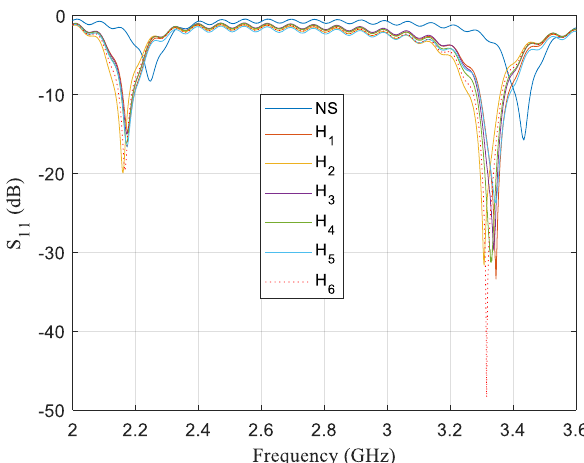
Figure 8. Frequency response of a 13 mm circular sensor for a single test where the sensor is